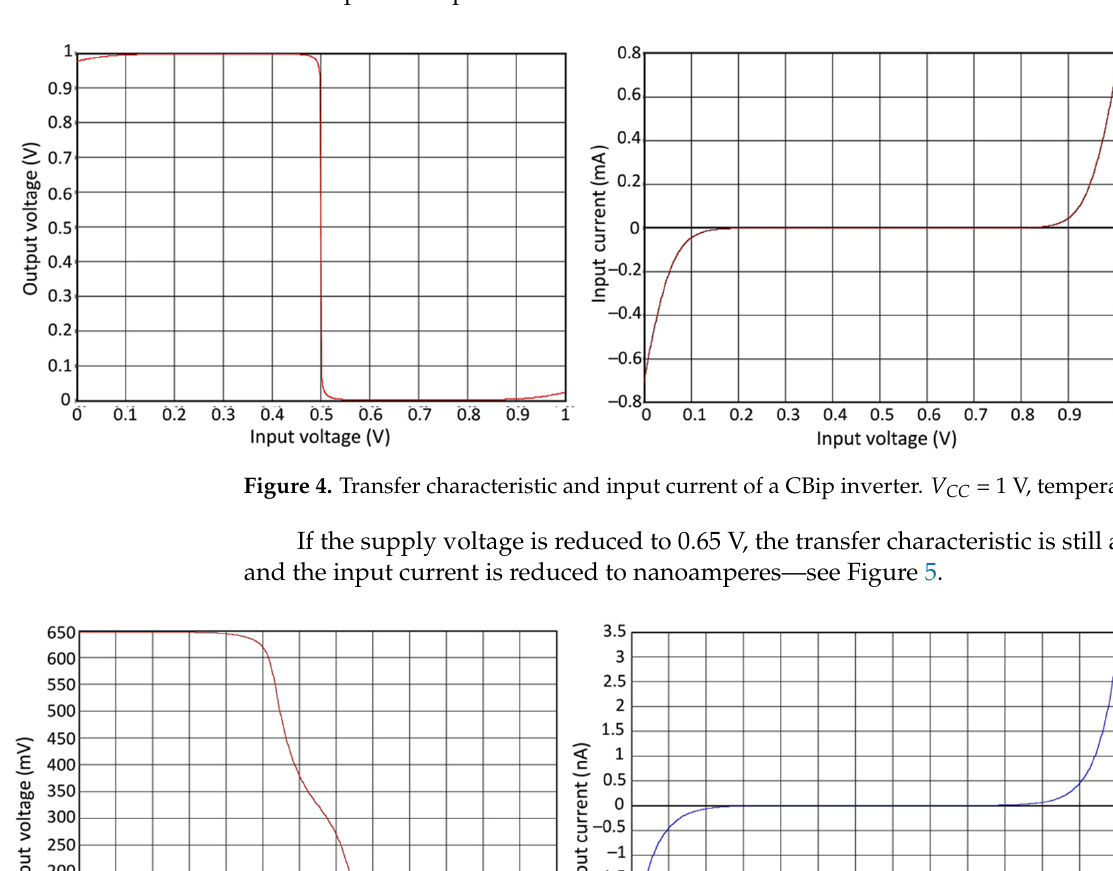
Figure 4. Transfer characteristic and input current of a CBip inverter. V CC = 1 V, temperature 300 K.